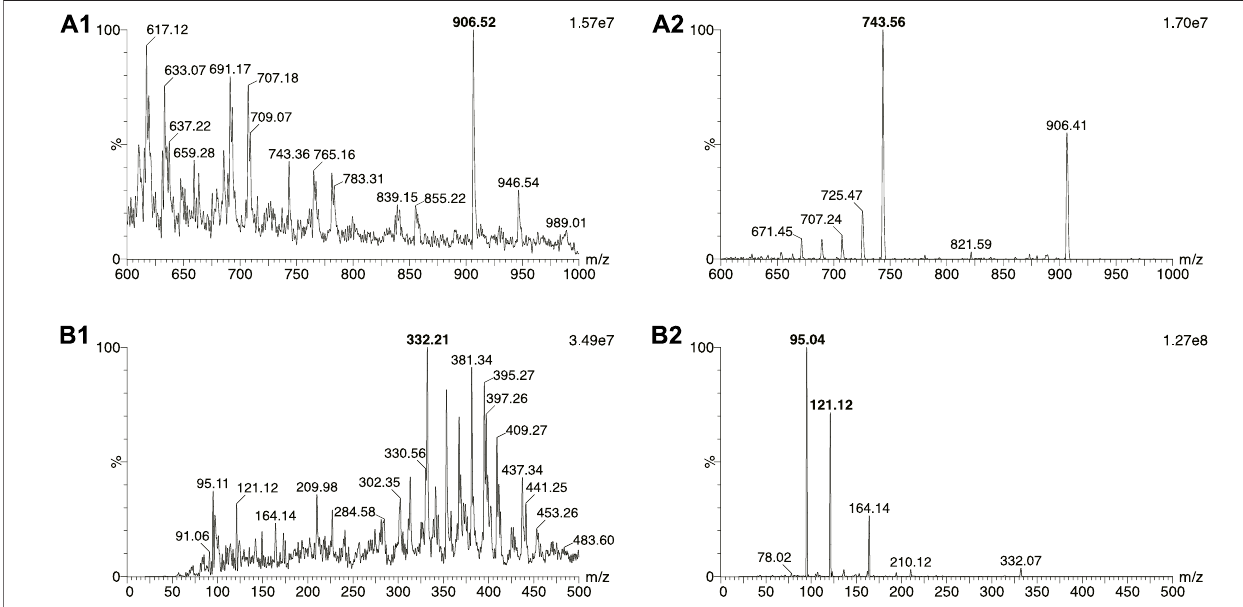
FIGURE 2 | Mass spectra of (A1) amphotericin B and (B1) internal standard piroxicam, and their respective product ions (A2, B2) .